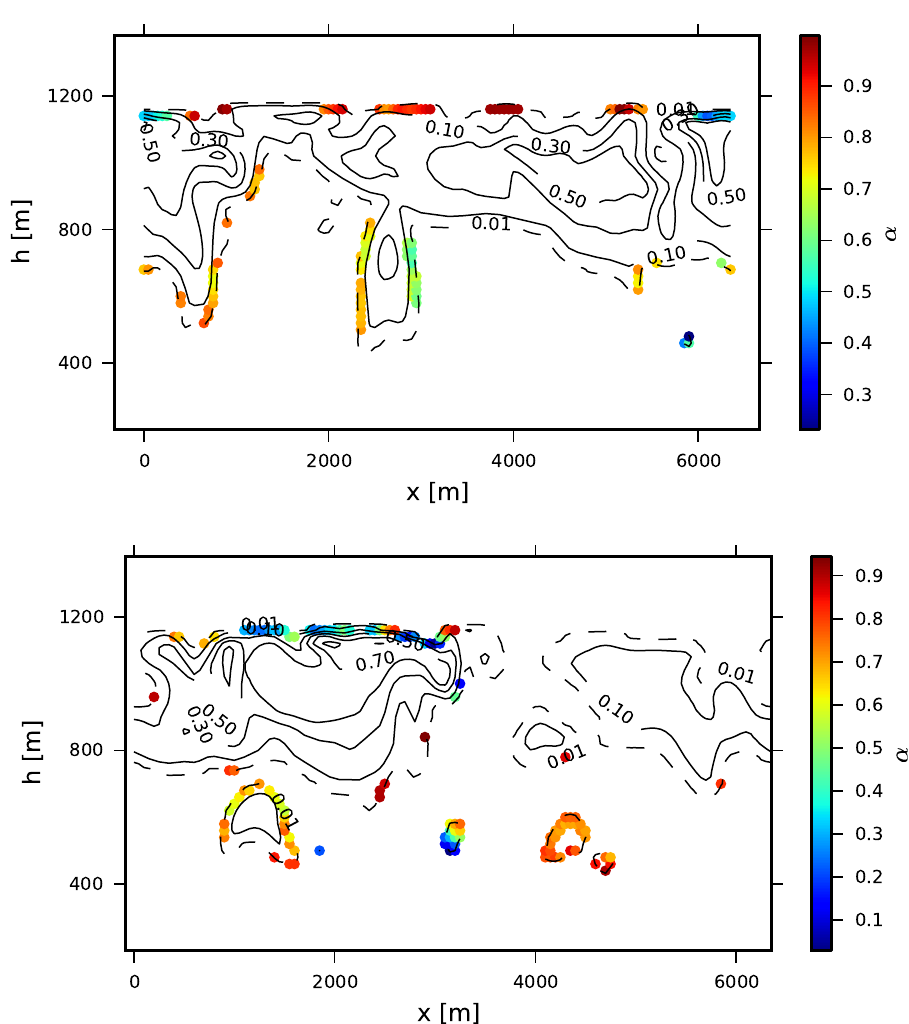
Fig. 7. Snapshots of the cloud water field in two vertical cross sections of the computational domain at time of t = 6h. Black solid lines show isolines of the cloud water mixing ratio; 0.01gkg − 1 isoline is shown by the dashed line. Color marks local values of the parameter α at the points undergoing turbulent cloud–environment mixing.